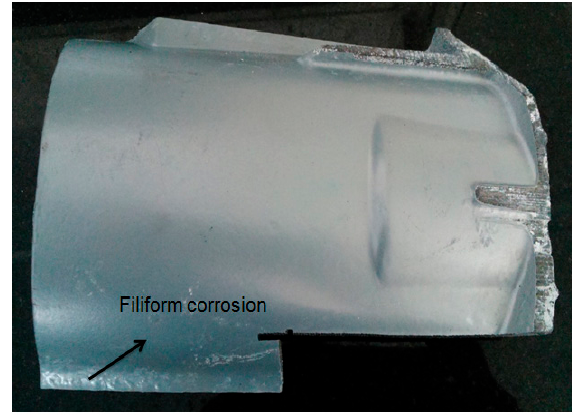
Figure 12. 3-coat polyester with epoxy primer.